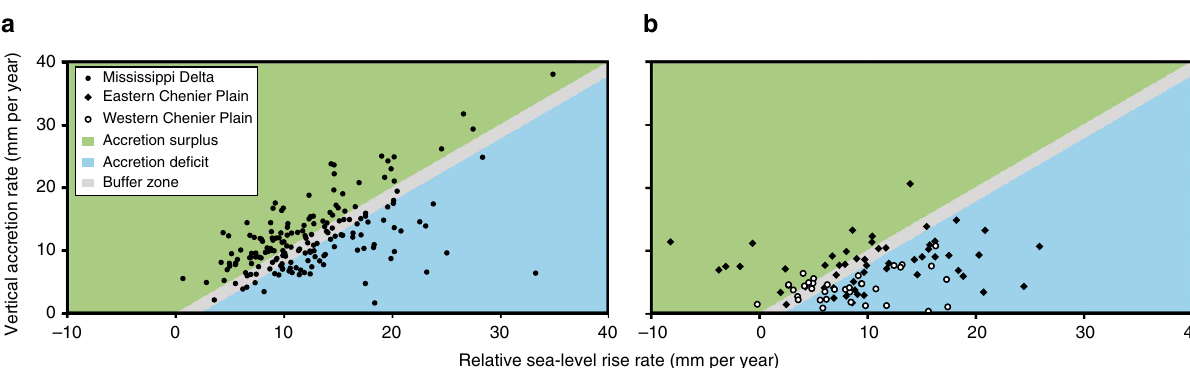
Figure 5 | Vulnerability of coastal Louisiana wetlands to present-day rates of RSLR. ( a ) Mississippi Delta; ( b ) Chenier Plain. Sites that fall within the accretion surplus field have VA rates that exceed the rate of RSLR. Sites within the grey buffer zone have an accretion deficit that is o 2mm per year and are assumed herein not to be vulnerable (although this is uncertain). Sites that fall below this buffer zone have an accretion deficit 4 2mm per year and are considered vulnerable given current rates of RSLR. Outliers in the Mississippi Delta ( n ¼ 5, with 4 experiencing an accretion surplus) are not shown for ease of comparison between the two